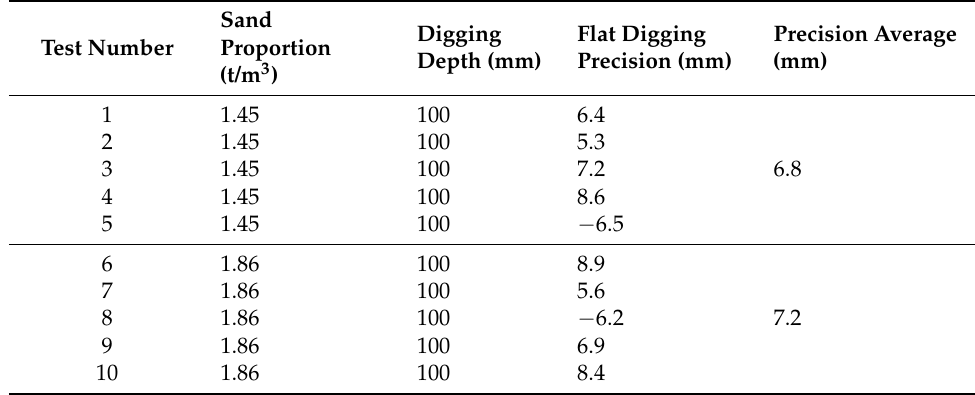
Table 3. Analysis of grab flat digging precision data.